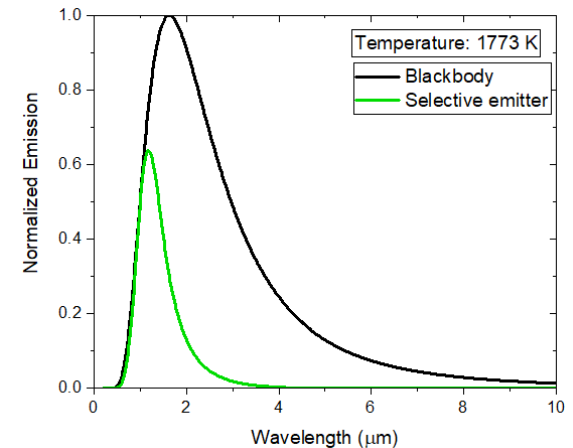
Fig. 2 : Normalized spectral radiation emitted by the BB (black line) and the designed selective emitter (green line) calculated at 1773